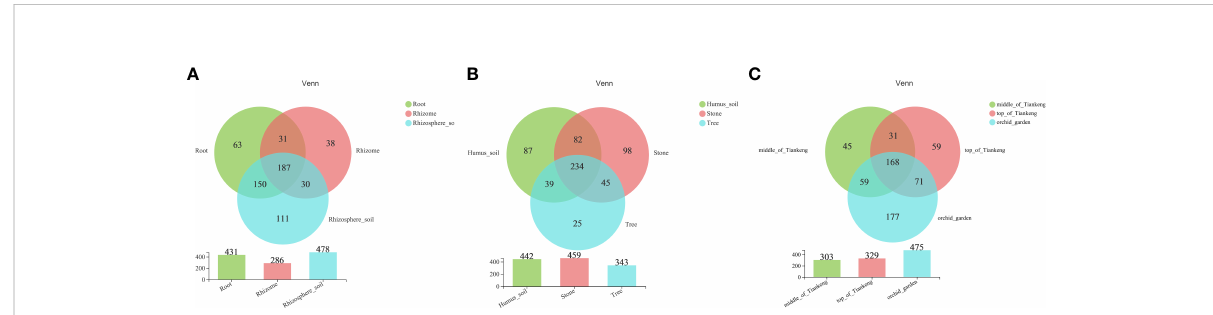
FIGURE 2 Venn chart. Different colors represent different groups, the number of overlapping parts represents the number of species shared by multiple groups, and the number of non-overlapping parts represents the number of species unique to the corresponding group. [ (A) : root, rhizome and rhizosphere soil groups; (B) : different habitat groups; (C) : different altitude groups].